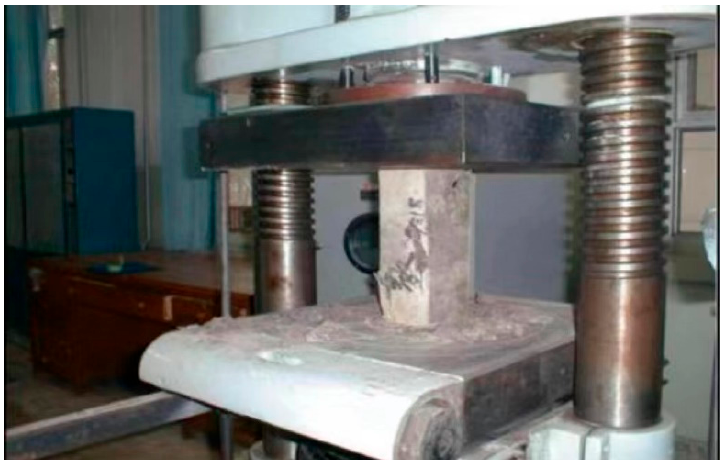
Figure 2. Concrete specimens and test apparatus.